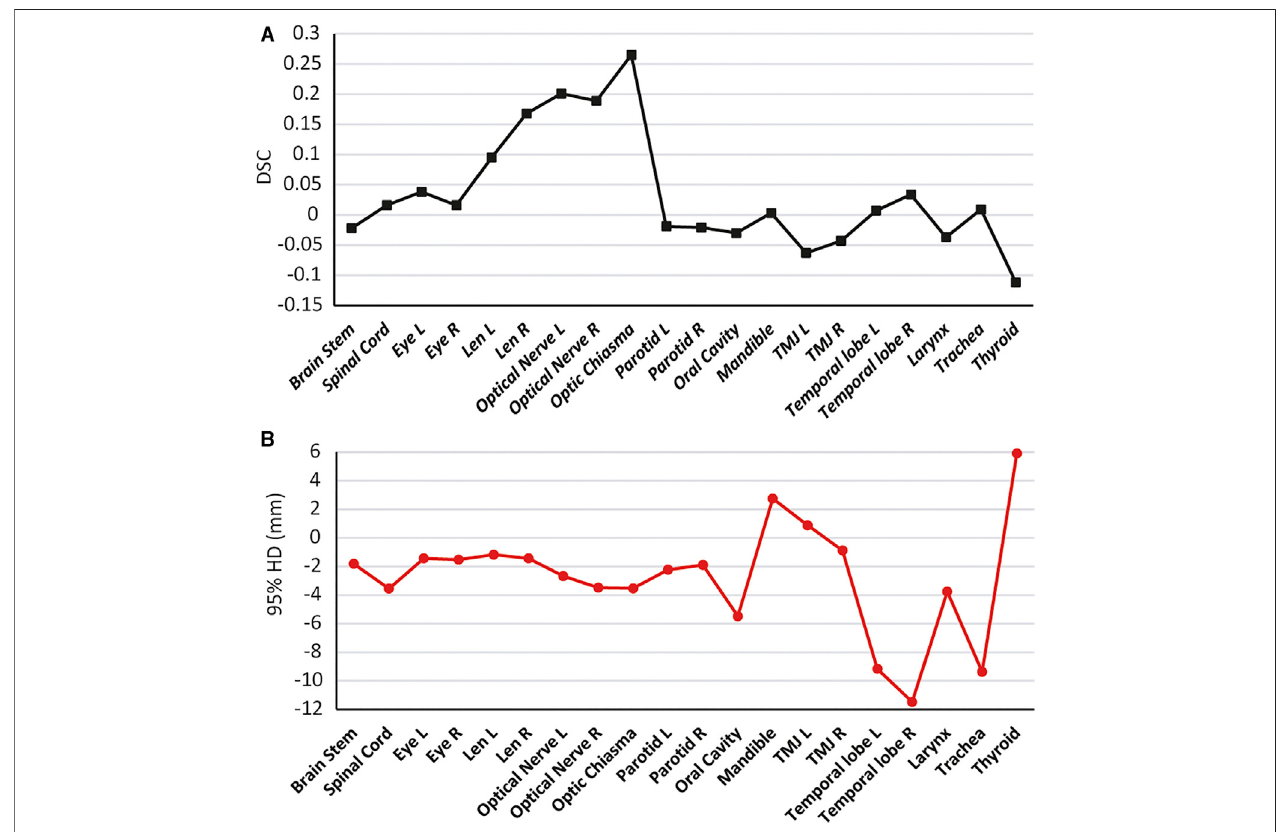
FIGURE 8 | Quantitative comparison of SEB-Net method with Ua-Net method. (A) : Comparison of DSC. (B) : Comparison of 95% HD.